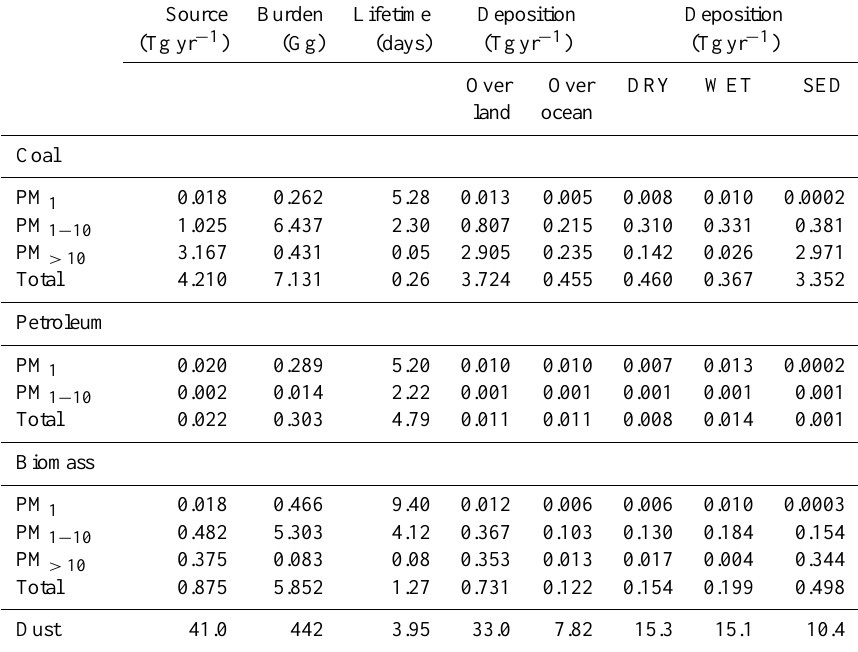
Table 4. Global Fe budgets from various sources and from different particle size classes. The total deposition of Fe was calculated over land and oceans separately, and was also calculated for the dry deposition (DRY), wet deposition (WET), and sedimentation (SED), respectively. Source Burden Lifetime Deposition Deposition (Tg yr − 1